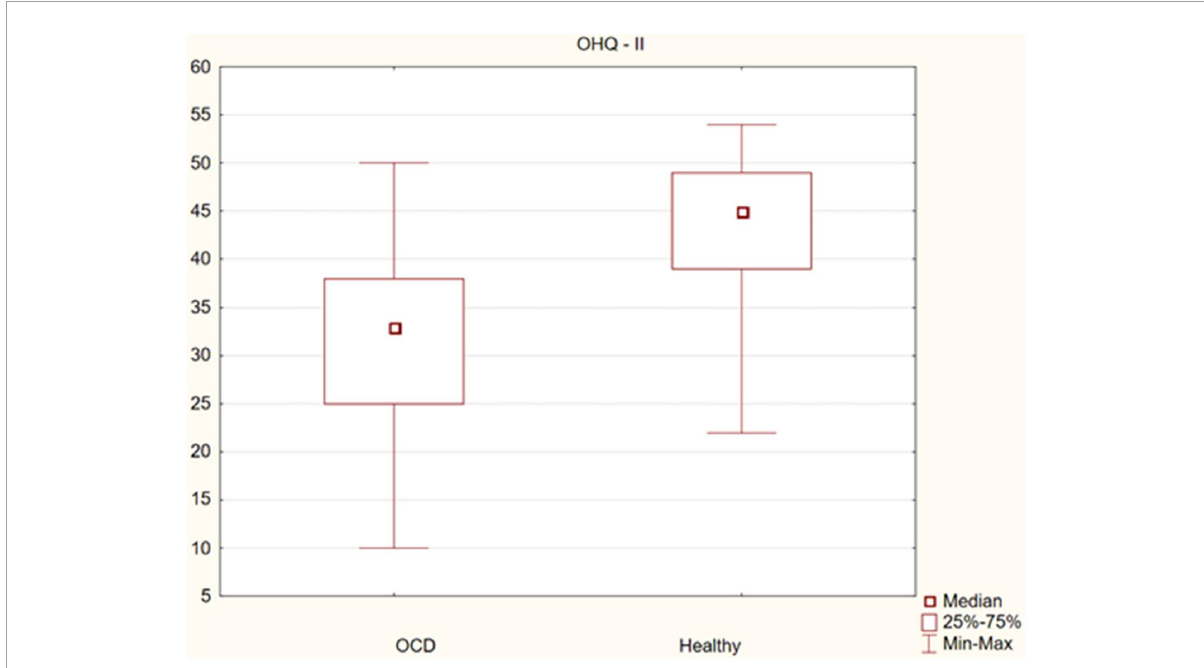
FIGURE3 Differences in the sense of life meaning and perceived control between obsessive-compulsive disorder (OCD) patients and healthy